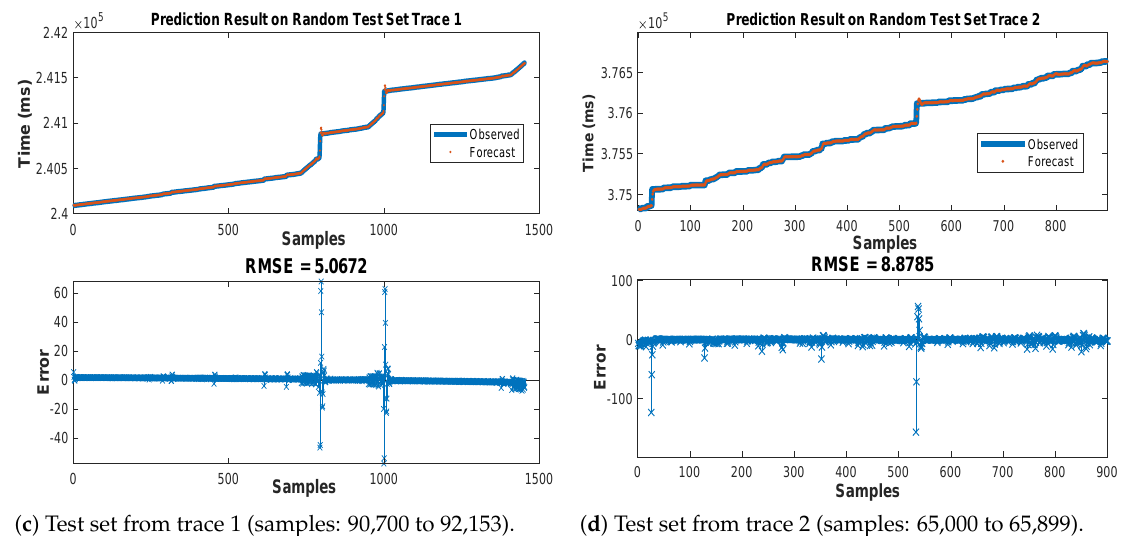
Figure 9. Prediction results and RMSE for random test